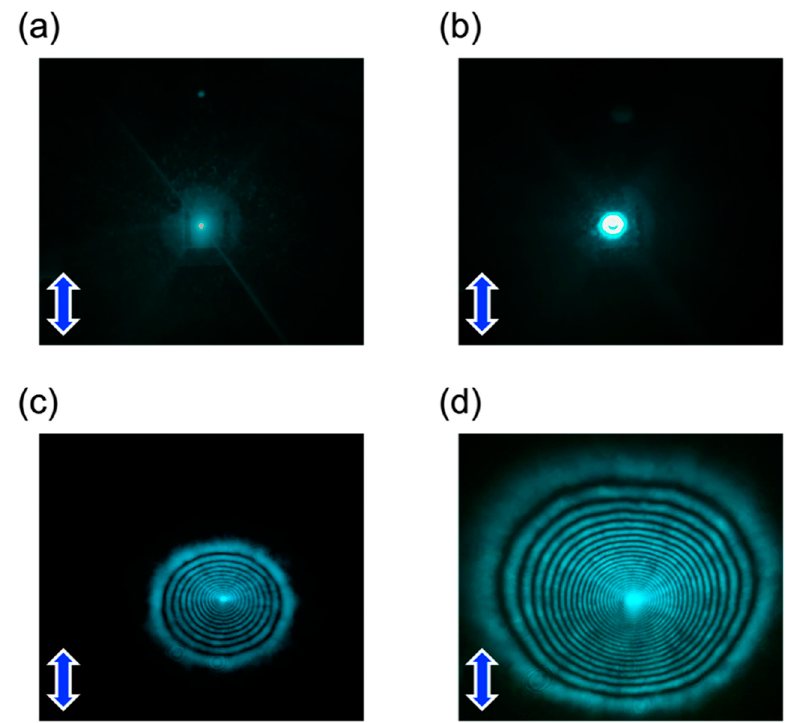
Figure 6. Diffraction ring images of TR5/5CB with the incident light intensity of ( a ) 15, ( b ) 20, ( c ) 27, and ( d ) 55 W/cm 2 . Blue arrows indicate the polarization direction of the incident light. The threshold light intensity inducing the diffraction rings depended on the host LCs.